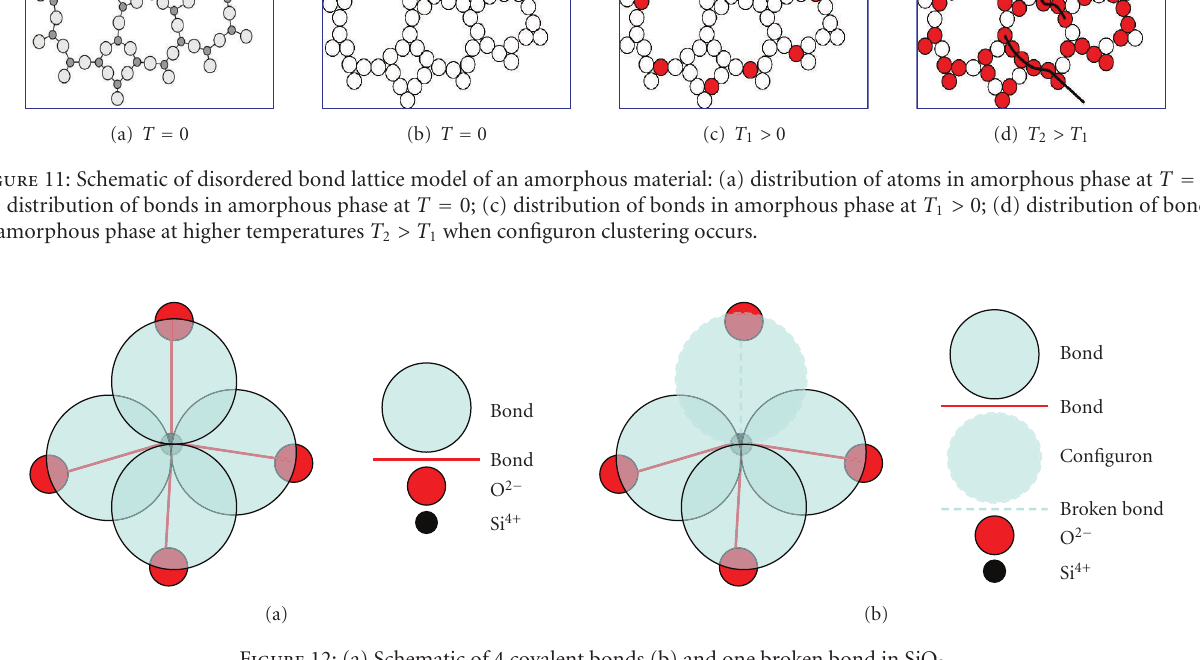
Figure 12: (a) Schematic of 4 covalent bonds (b) and one broken bond in SiO 2